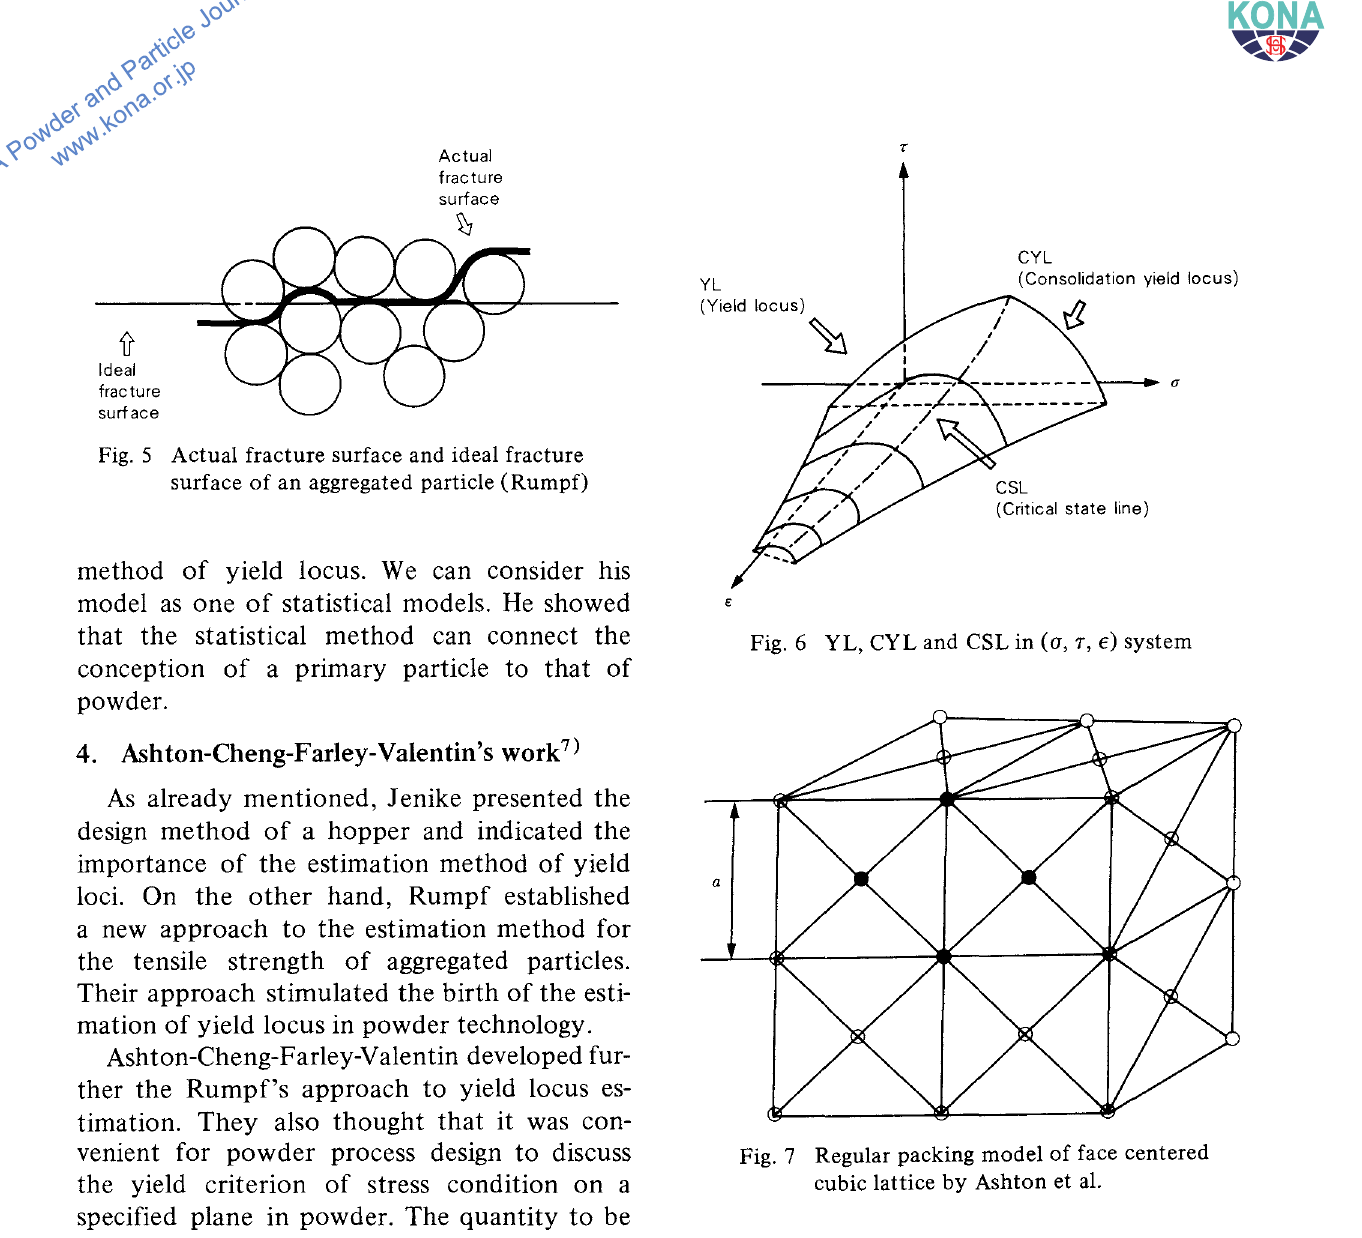
Fig. 7 Regular packing model of face centered cubic lattice by Ashton et